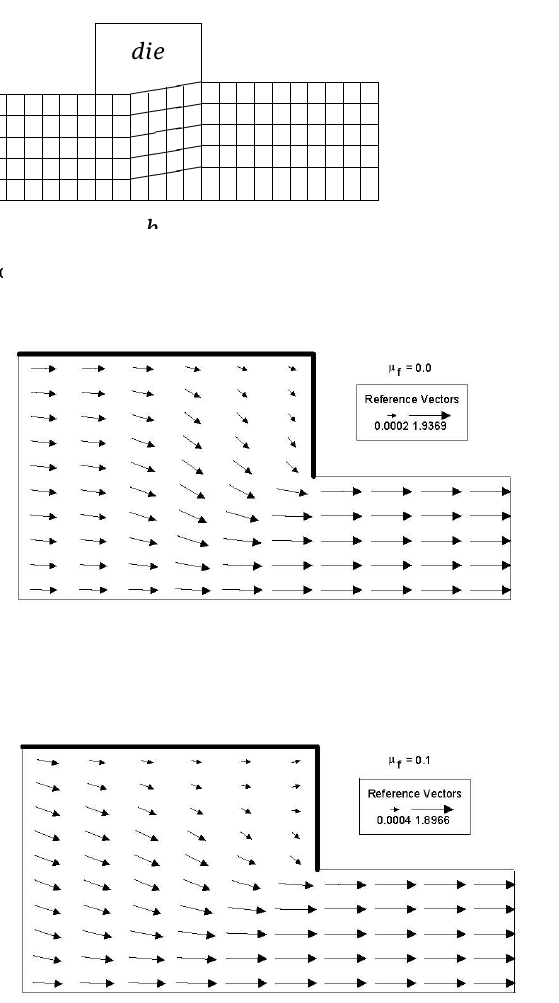
Fig. 3. Velocity vectors at friction coefficients µ f = 0.0 and µ f = 0.1 . rates, for the two friction coefficients, are illustrated